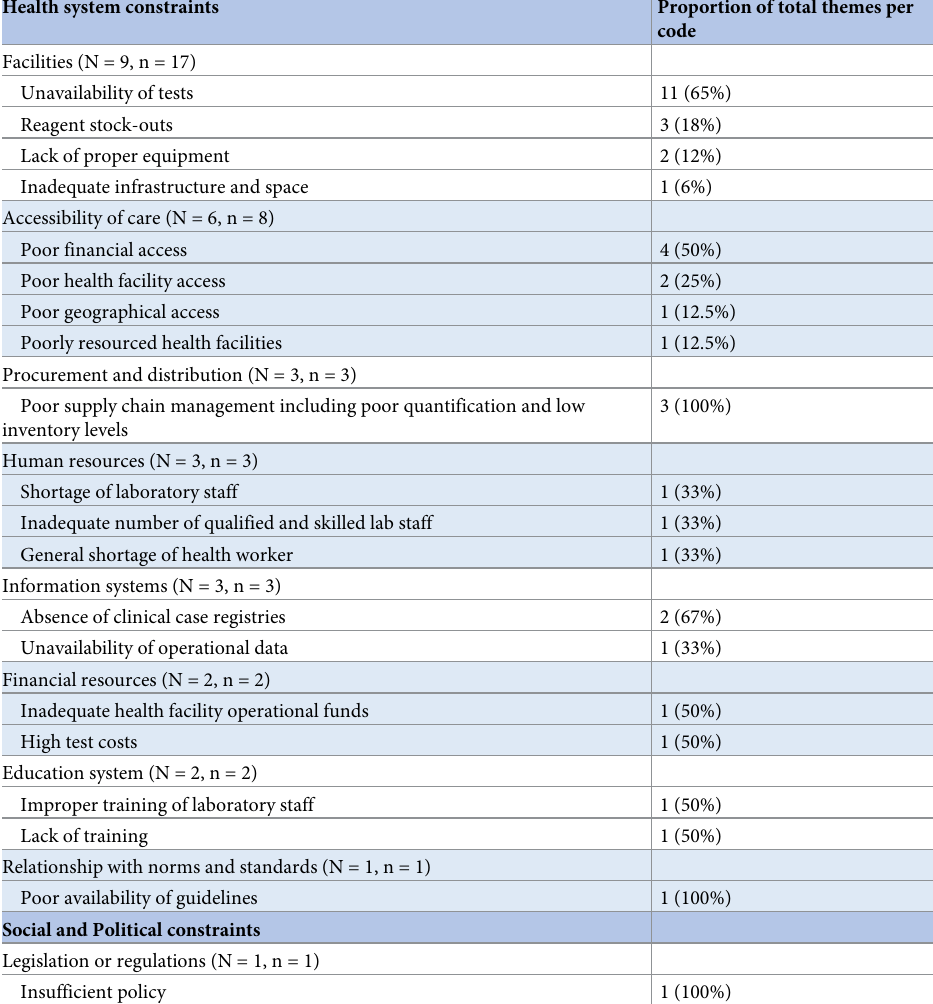
Table 3. Thematic content analysis of applied SURE codes to barriers to the implementation of